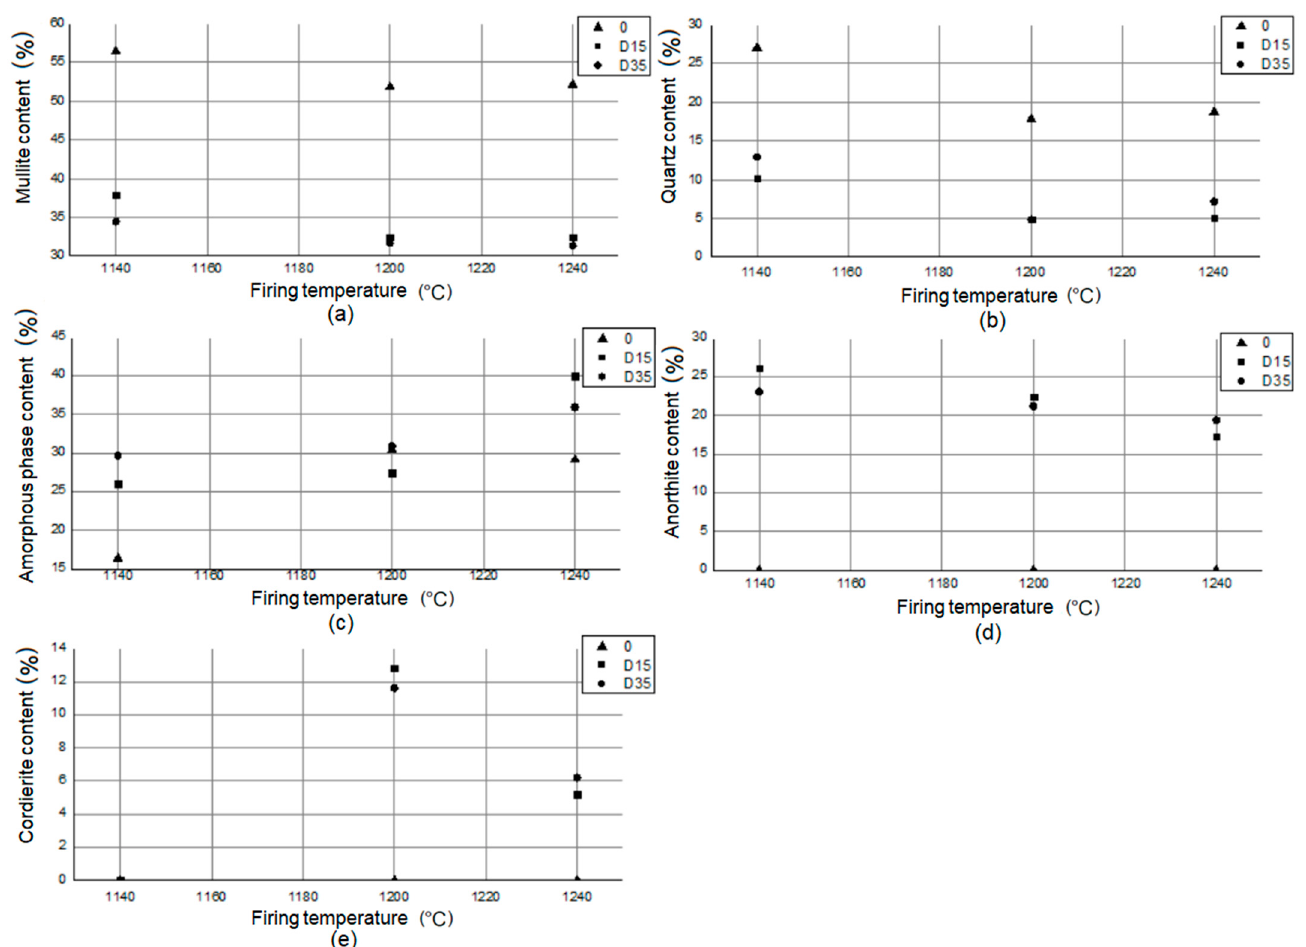
Figure 9. Relationship between ( a ) mullite, ( b ) quartz, ( c ) amorphous phase, ( d ) anorthite, and ( e ) cordierite content in phase composition of materials and firing temperature.